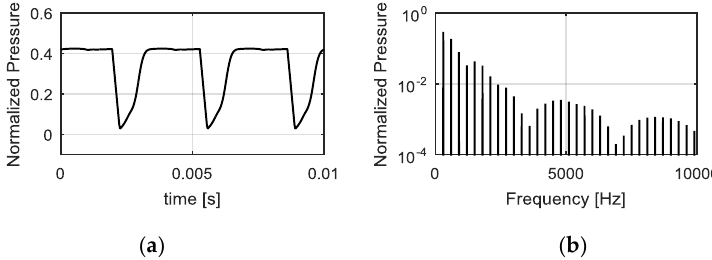
Figure 11. Pressure ripples at the TSV pressure regions at θ = 51° for the drive gear depending on time ( a ) and frequency ( b ).